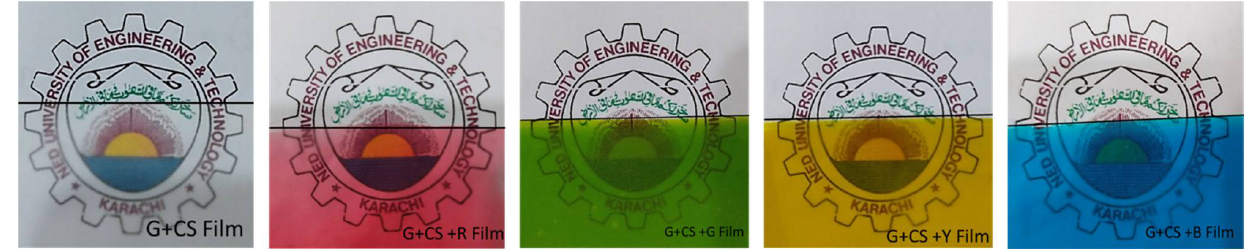
Figure 4. Transparency of the edible films (the black line indicates the film area). The background image is the logo of NED University of Engineering and Technology.